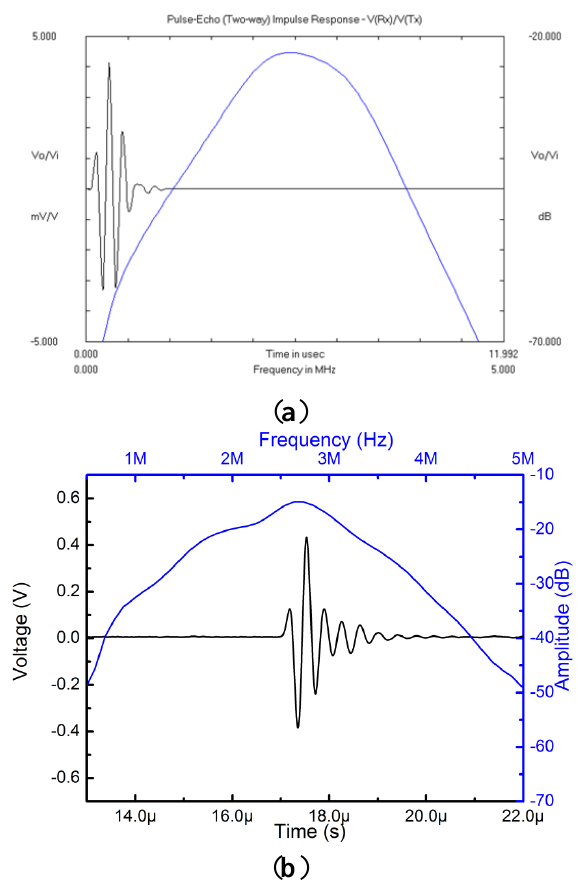
Figure 5. ( a ) Modeled and ( b ) measured pulse-echo waveform and frequency spectra of the 1-3 composite